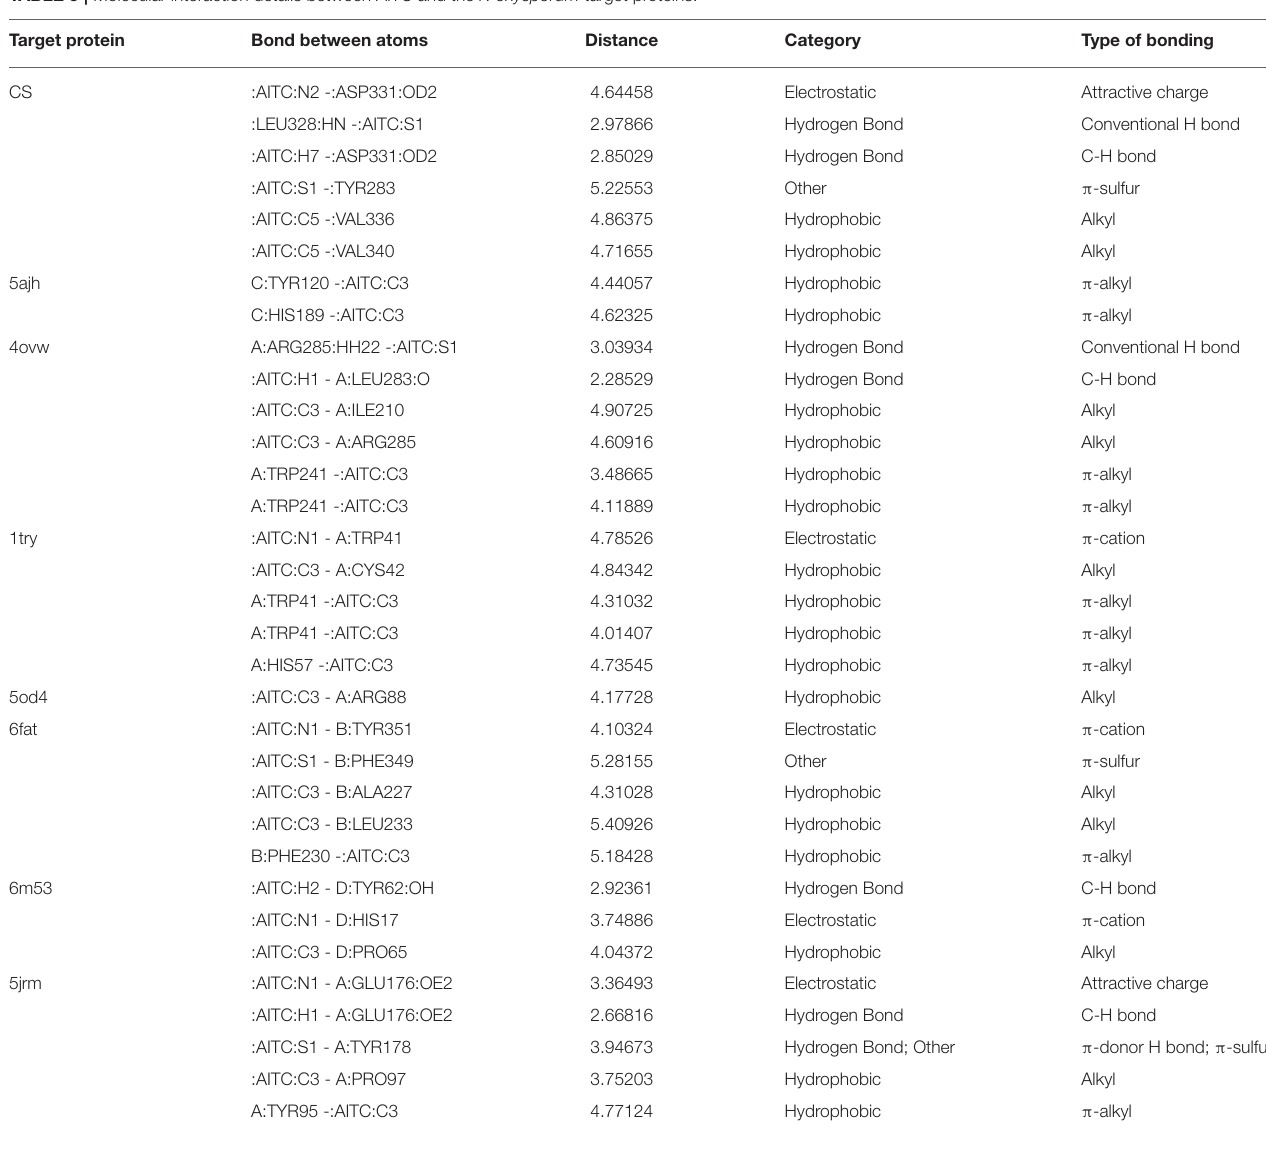
TABLE 5 | Molecular interaction details between AITC and the F. oxysporum target proteins. Target